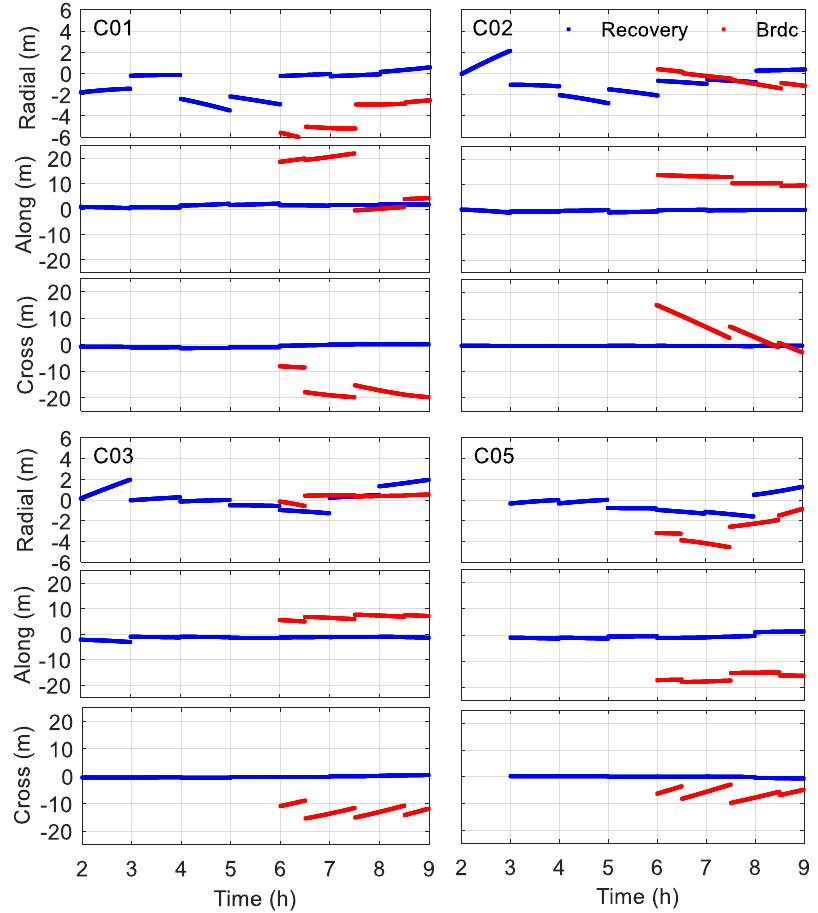
Figure 6. Errors of the orbit recovery results and healthy broadcast ephemerides of GEO satellites in October 2017. Top left: C01 on 31 October, top right: C02 on 19 October, bottom left: C03 on 23 October, bottom right: C05 on 10 October.